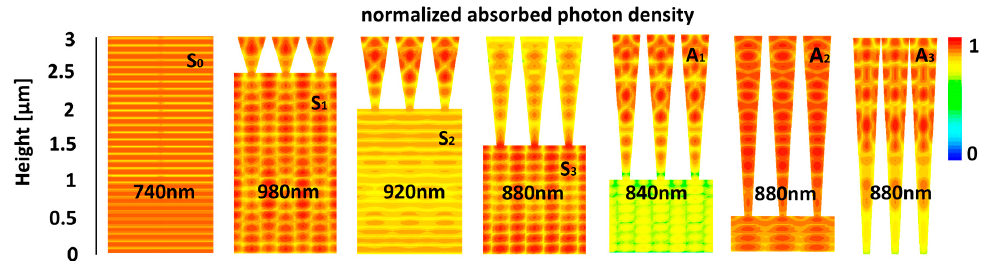
Figure 3. 3D FDTD results of the normalized absorbed photon density for various geometries and wavelengths. The S0–S3 and A1–A3 notations refer to Figure 2a–c. The cross-sections are normal to the plan of incidence.